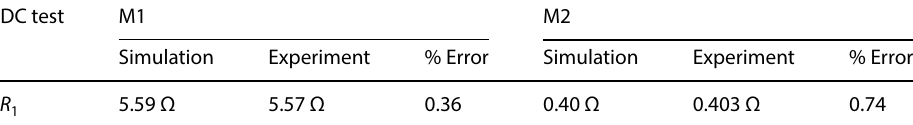
Table 3 Comparison of DC test simulation result with experiment result